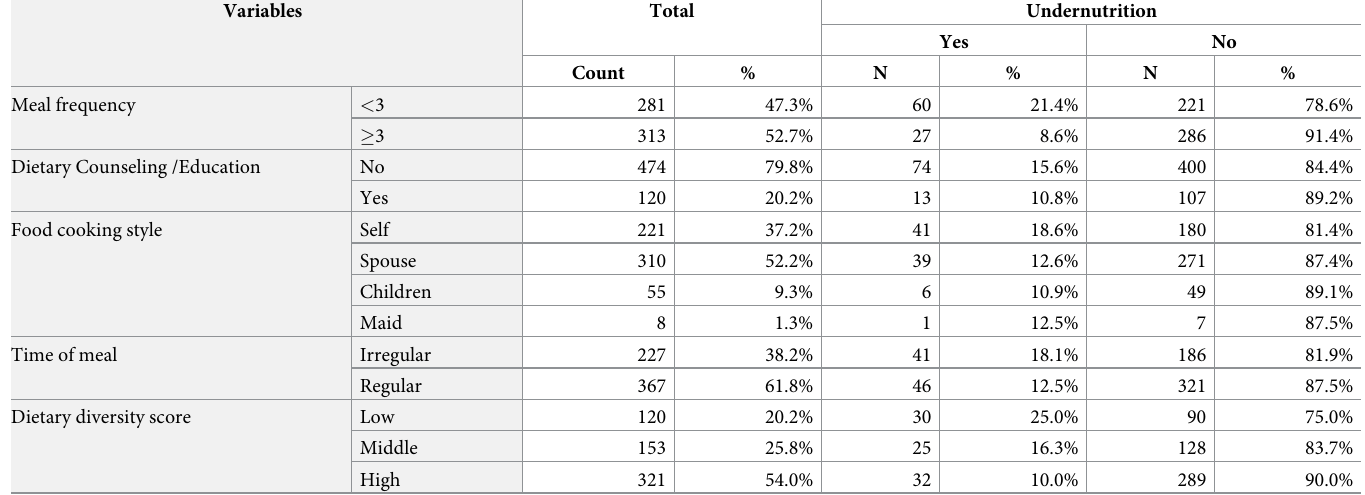
Table 2. Distribution of nutrition related characteristics of undernutrition among the older adults in Womberma district, North West Ethiopia, 2020 (n = 594). Variables